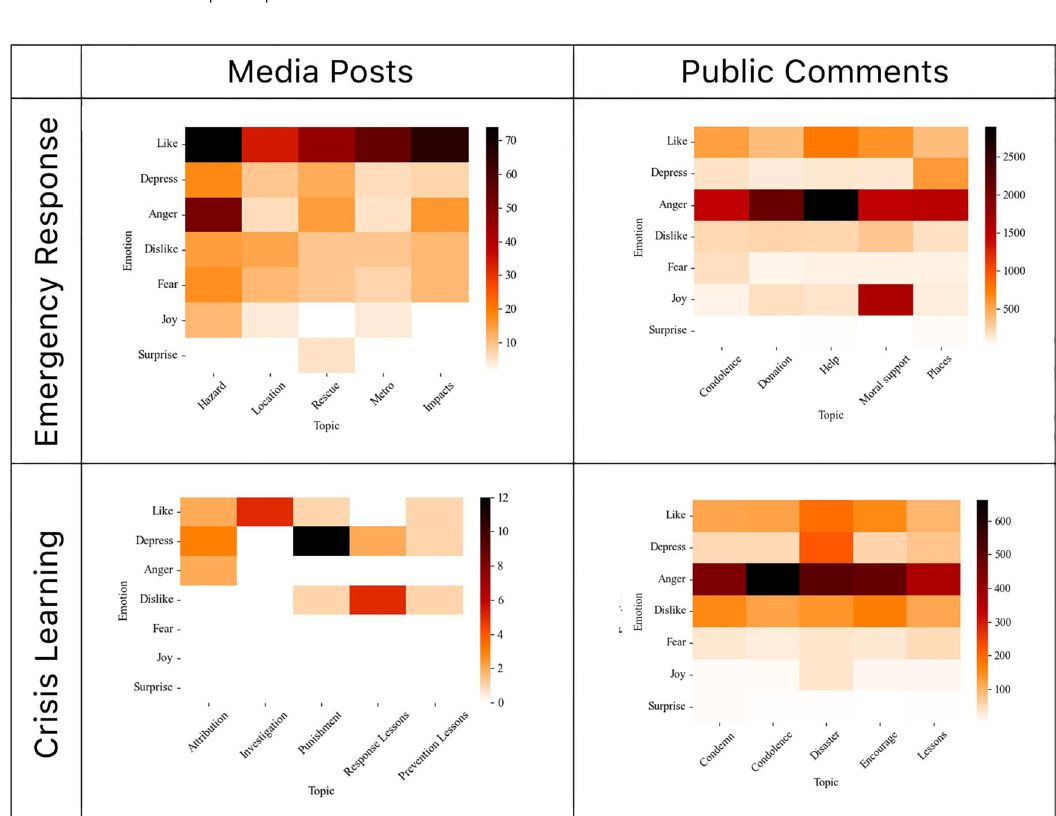
Fig. 4 Emotions by